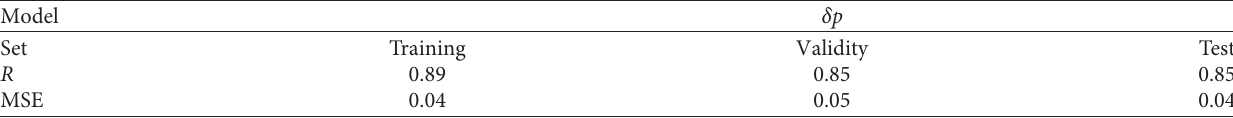
Table 6: Performance of the ANN generated for the DP model.